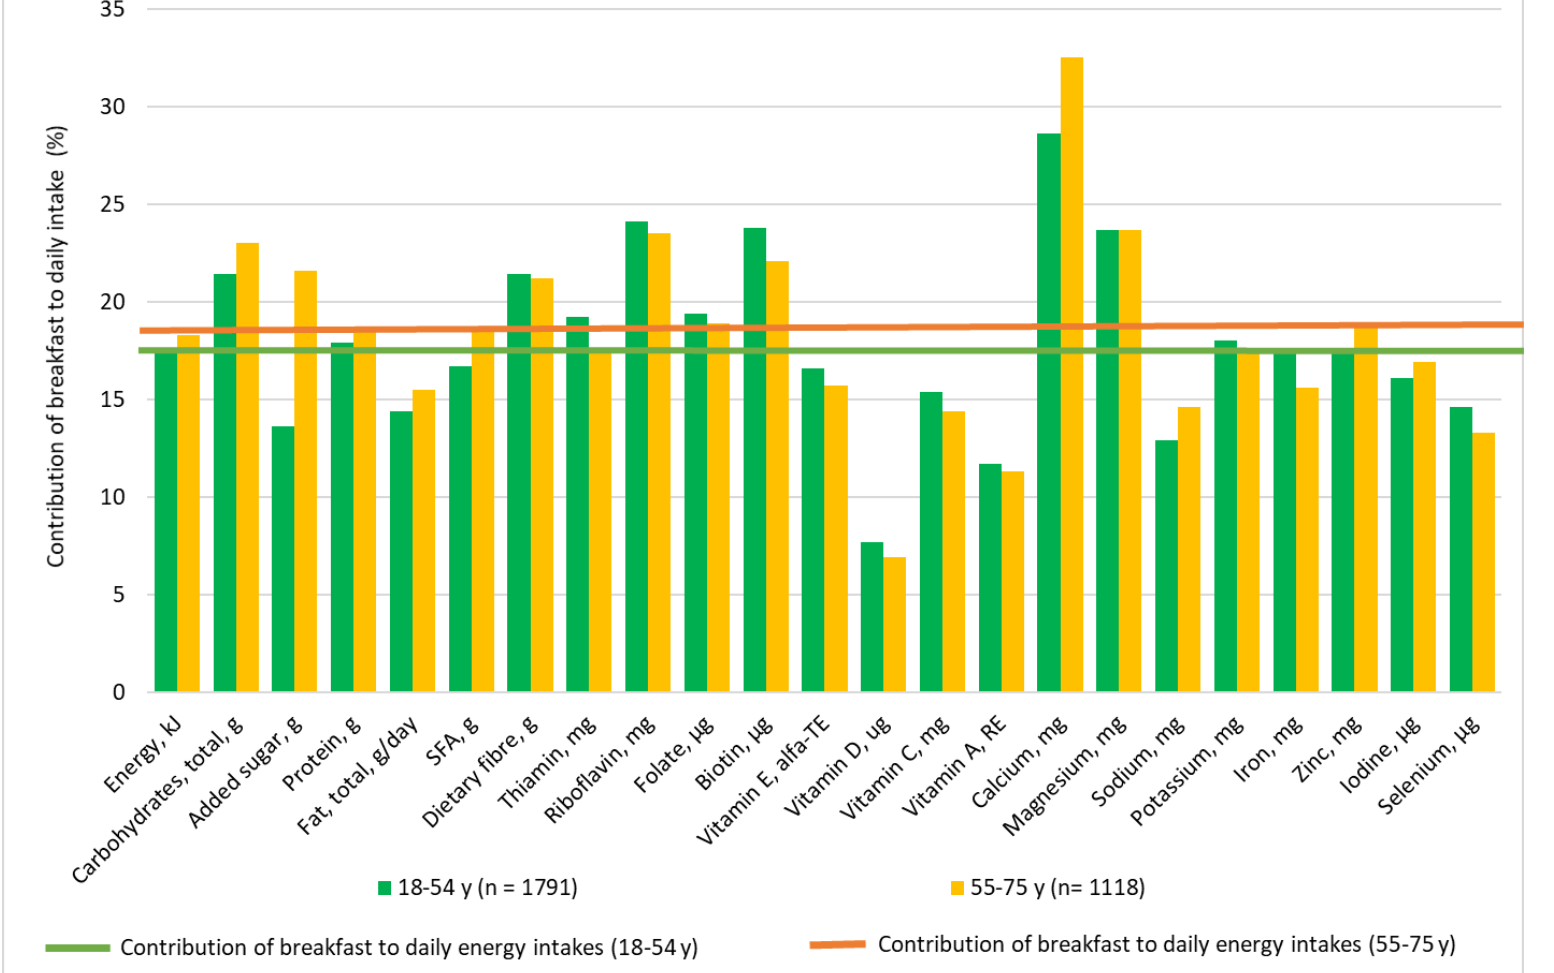
Figure 3. The contribution of breakfast (%) to the daily nutrient intakes in 18–54 and 55–75 year-old Danes.